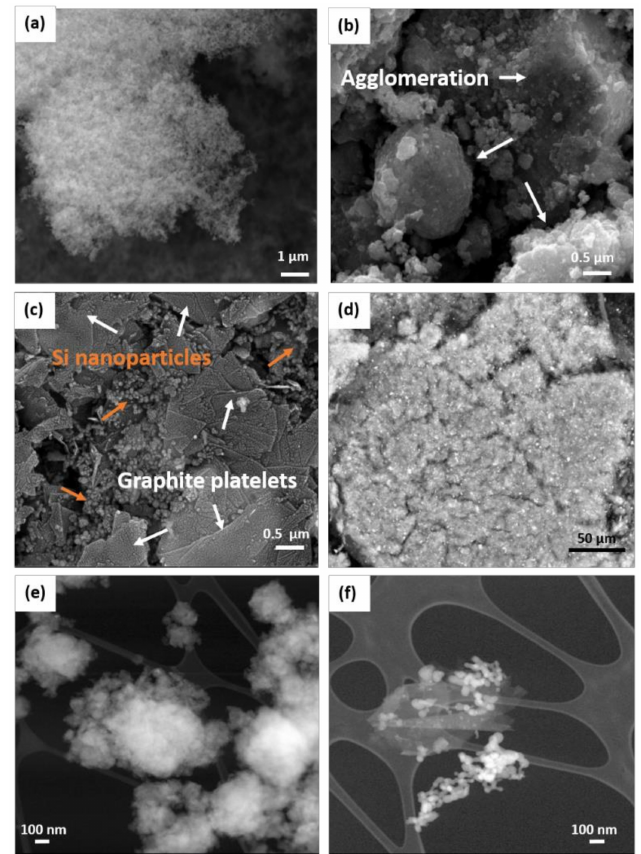
Figure 3. Scanning electron microscopy (SEM) micrographs of ( a ) Si nanoparticles (Alfa Aesar), ( b ) s-BMD, ( c ) s-BMW, ( d ) s-BMW backscattered image. Transmission electron microscopy (TEM) micrographs in dark field of ( e ) s-BMD and ( f )